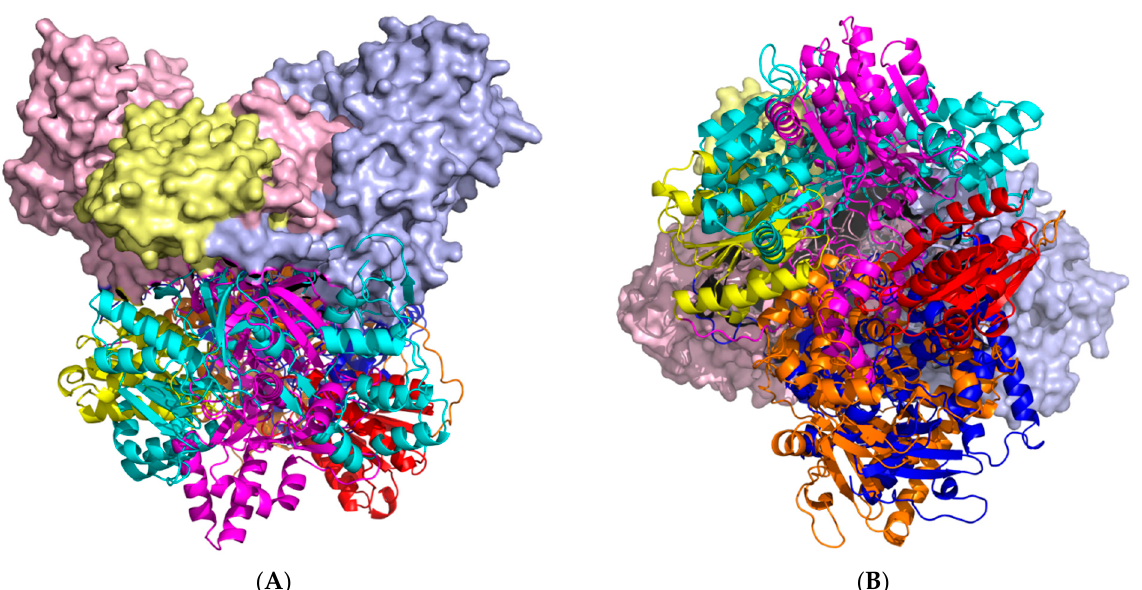
Figure 3. Alignment of monomer CYP102A1/WT predicted in AF2 to monomer from homodimer calculated using AFMultimer. The colours indicate the monomer domains: heme domain (orange), FMN domain (red), FAD domain (cyan). The surface denotes the second monomer of the homodimer, where light blue is heme domain 2, pale yellow is FMN-domain 2, light pink is FAD-domain 2. ( A ) shows a planar view of a superposition of 2 structures, where in ( B ) a downward rotation of 90 degrees along the horizontal axis is shown.